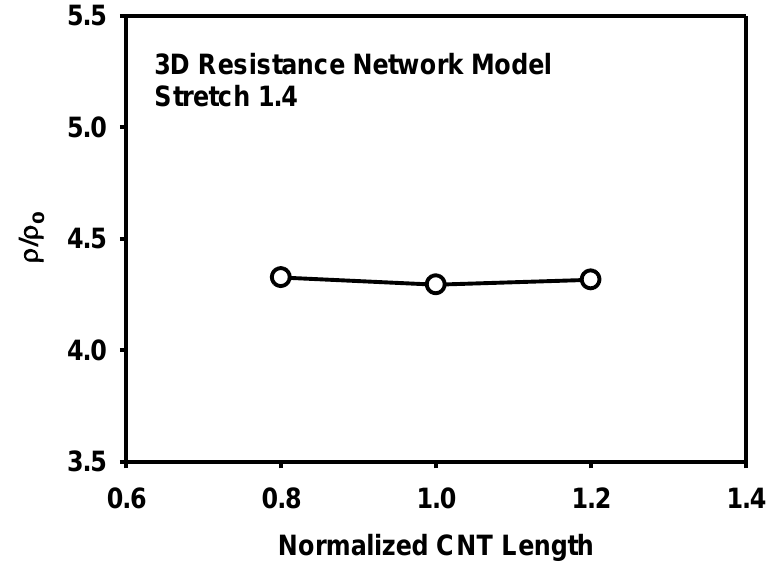
Figure 18. Effect of the CNT length on the resistivity as calculated by the 3D resistance network model.